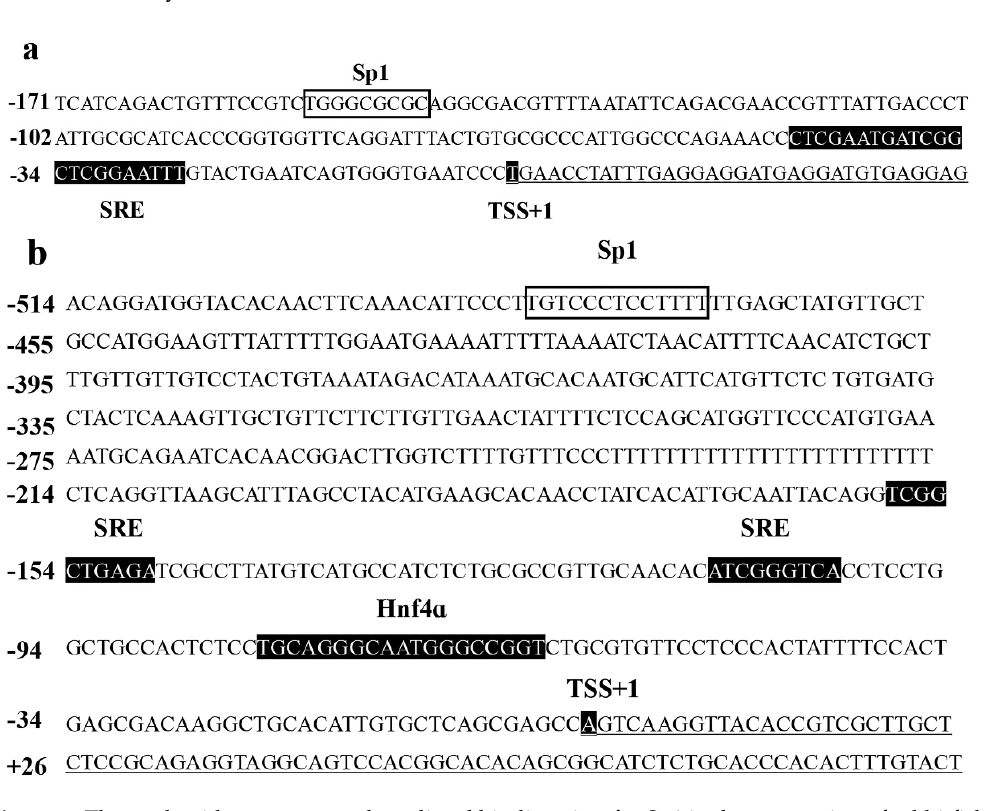
Figure 5. The nucleotide sequence and predicted binding sites for Sp1 in the core region of rabbitfish ∆ 6 / ∆ 5 fads2 ( a ) and elovl5 ( b ) promoters. Numbers are given relative to the first base of the transcription start site (TSS, + 1). Potential transcription binding motifs are marked in black or open boxes for Sp1. The bases underlined are downstream sequence of TSS.